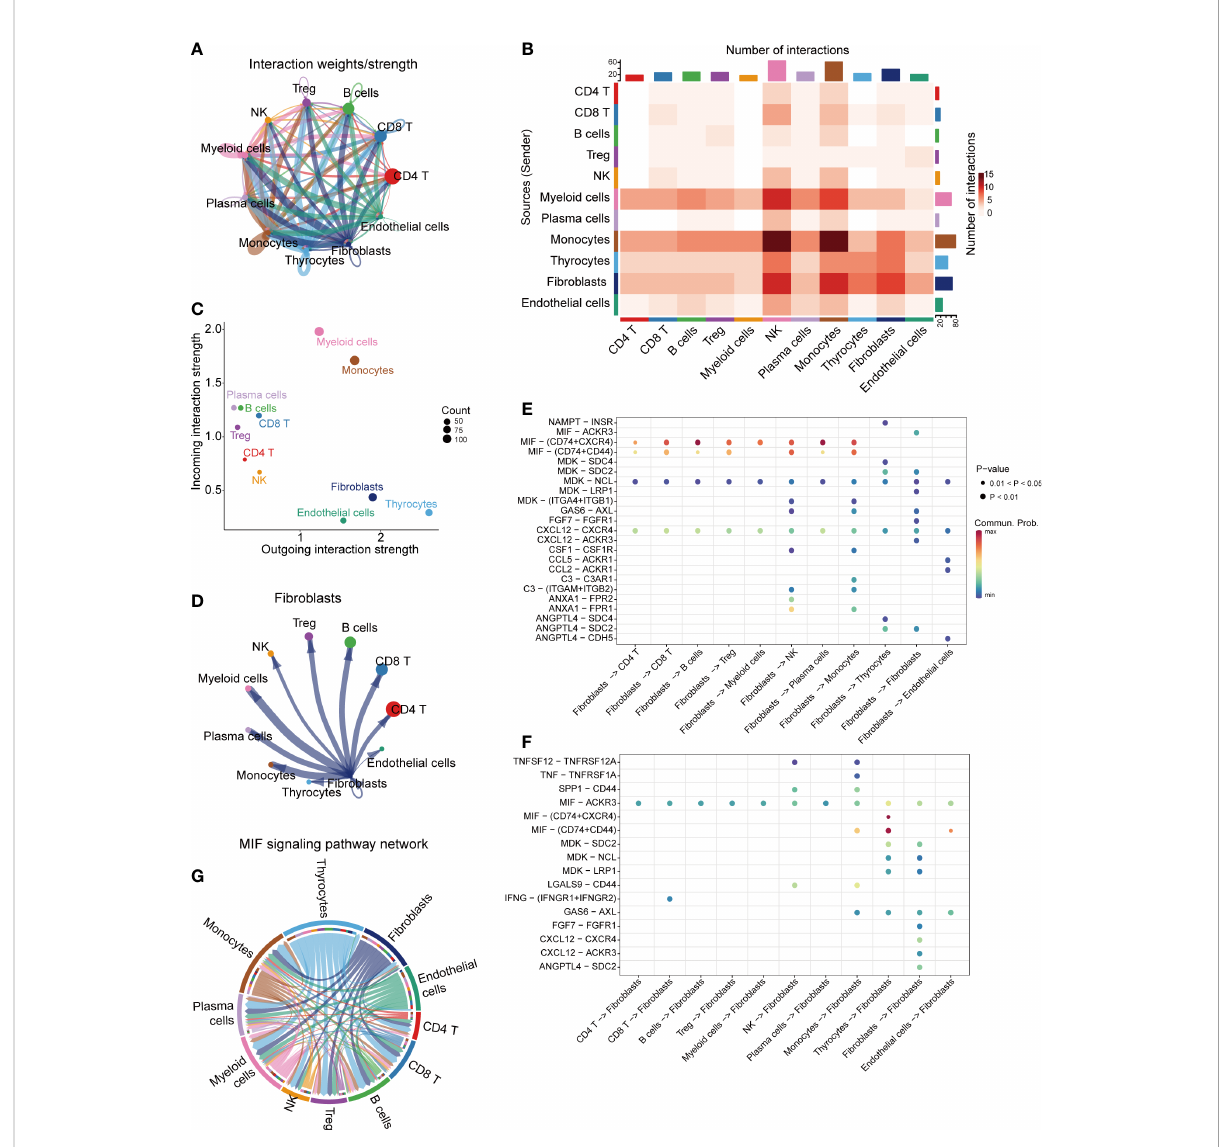
FIGURE 2 Cell-cell communications in thyroid cancer. (A) Integrated cell-cell communications network plotted by interaction weights. (B) The cell-cell communications heatmap. (C) The dot plot of outgoing/incoming interaction strength for 11 cell clusters. (D) Cell-cell communications network of fi broblasts. The dot plot of fi broblasts outgoing (E) and incoming (F) interaction signal pathways. (G) MIF signaling pathway